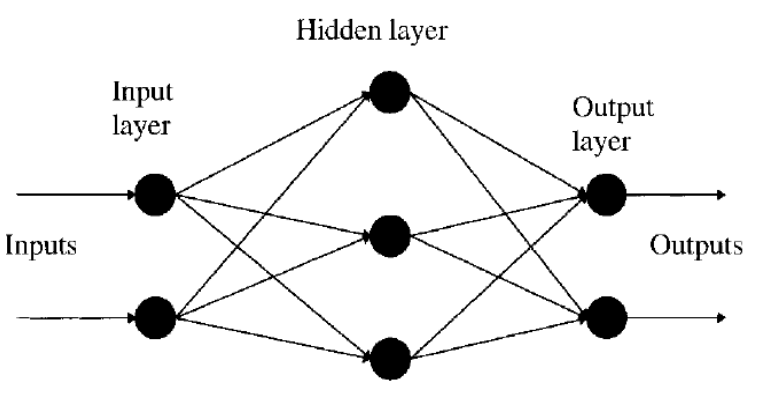
Figure 4. A representation of the general structure of an ANN, here with one hidden layer (adopted from